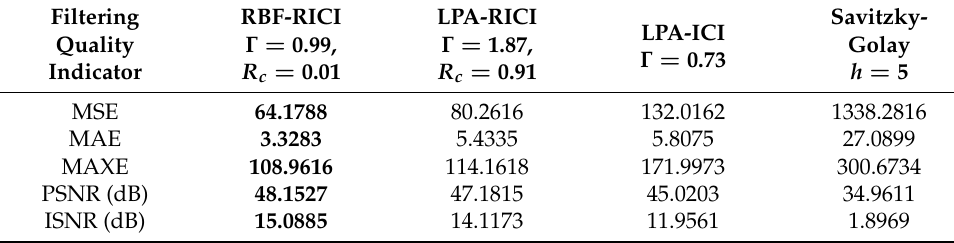
Table 37. Sing signal (SNR = 7 dB)—Filtering results.